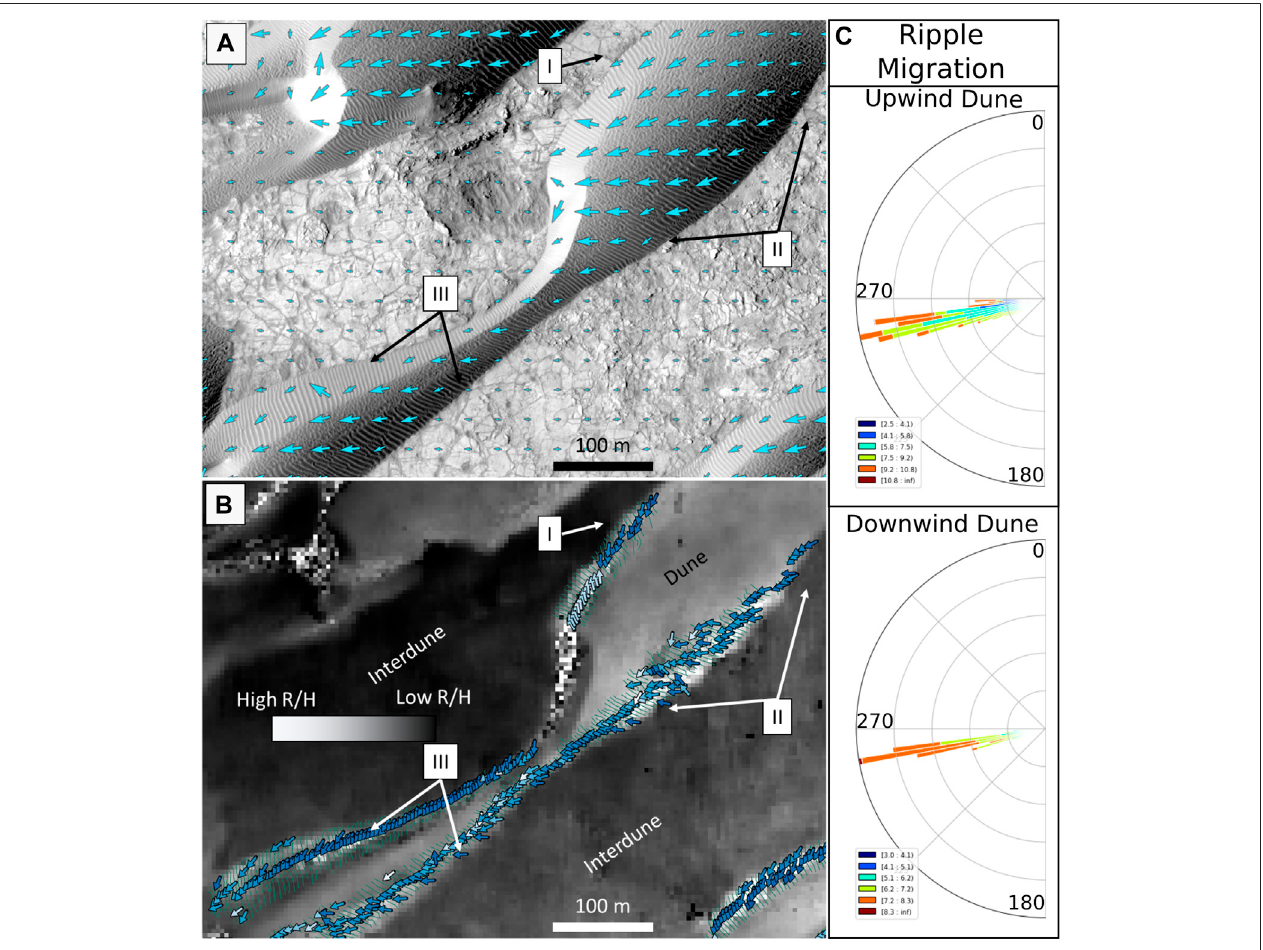
FIGURE 11 | Imagery and ripple migration directions (A) and Ripple migration rate over dune height (B) maps of site E with (C) rose diagrams of ripple migration direction and magnitude for each dune top. Site E captures a number of features that are commonly seen on these steep, ripple bearing slopes. Roman numerals and arrows indicate three 2-D ripples bearing slopes that demonstrate several observed